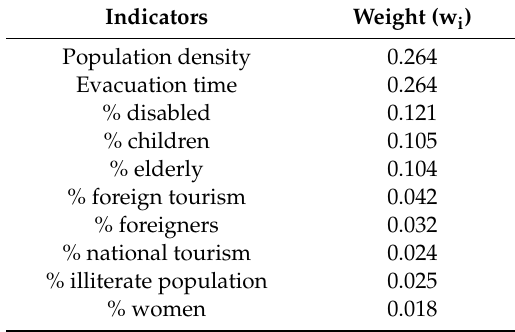
Table 3. Weights of indicators that indicate the exposure degree of social vulnerability.